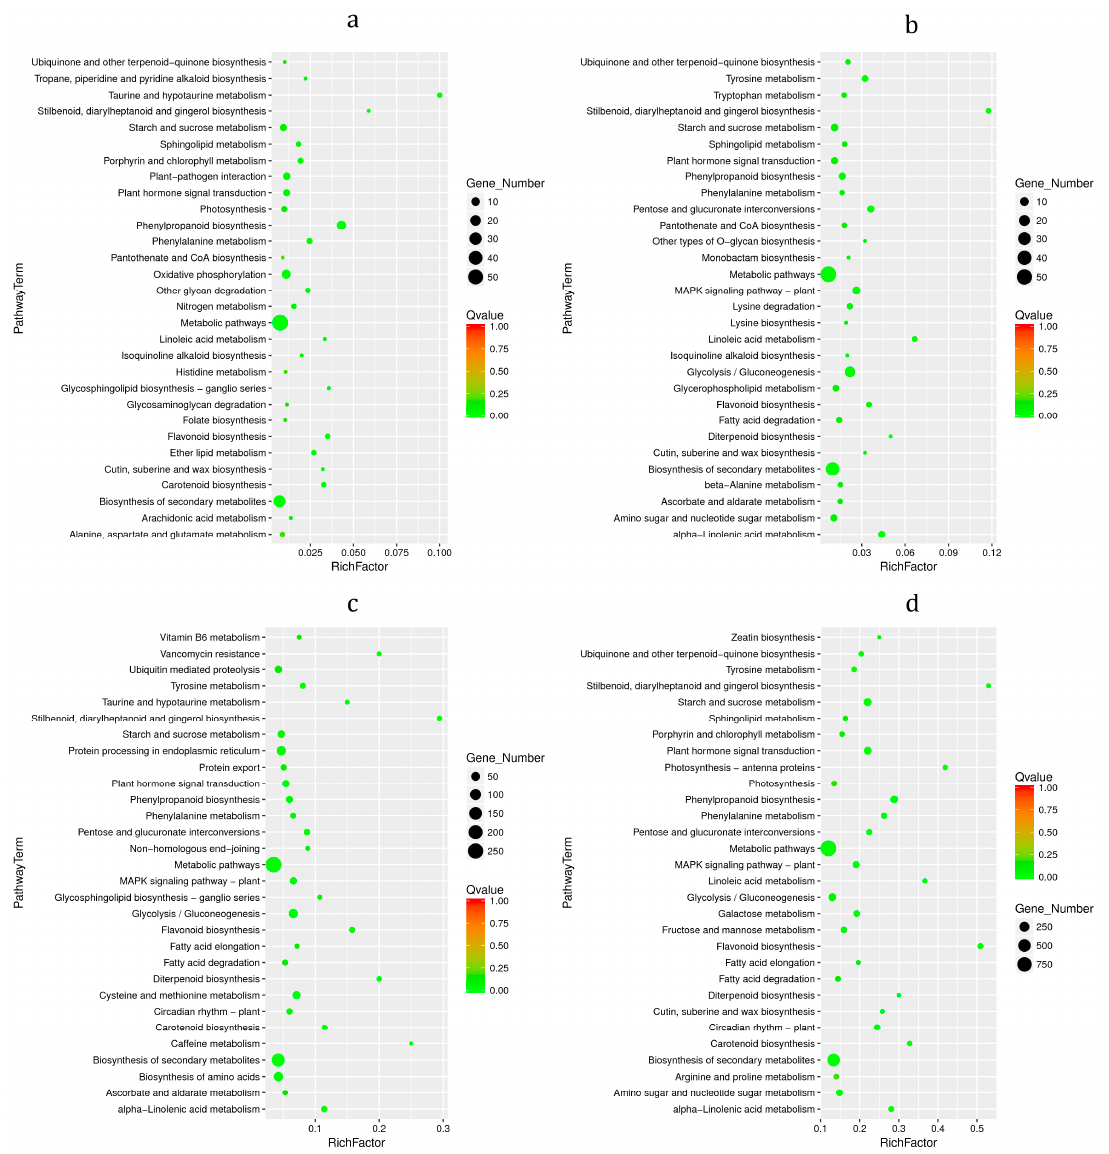
Figure 6. KEGG enrichment analysis of DEGs. Horizontal is number of rich-factor and ordinate is pathway term. The size of the dot represents the number of DEGs. Different colors of dots represent different Qvalues. ( a ) bx1 vs. ck1; ( b ) bx2 vs. ck2; ( c ) bx3 vs. ck3; ( d ) bx4 vs.